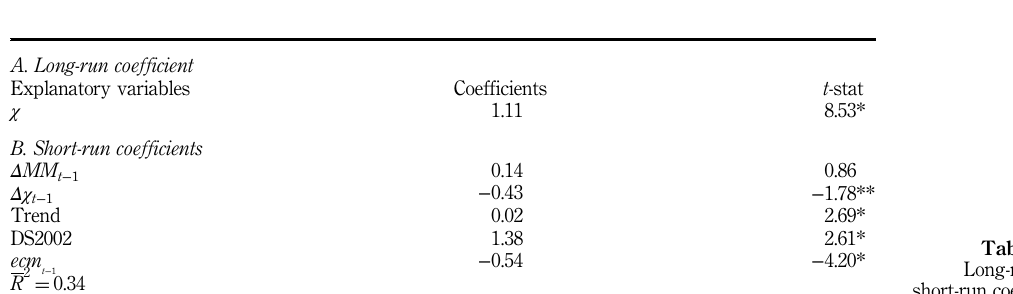
Table VII. Long-run